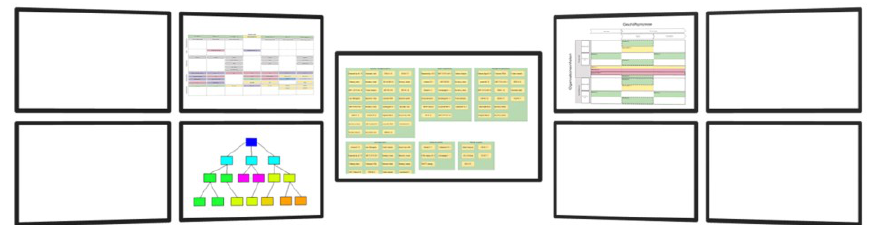
Figure 3. Example: Enterprise Architecture Cockpit [49],